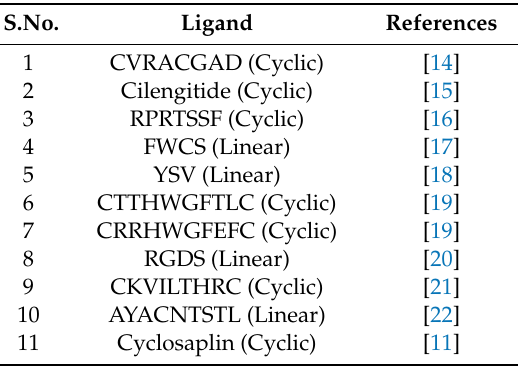
Table 1. Ligands used in the